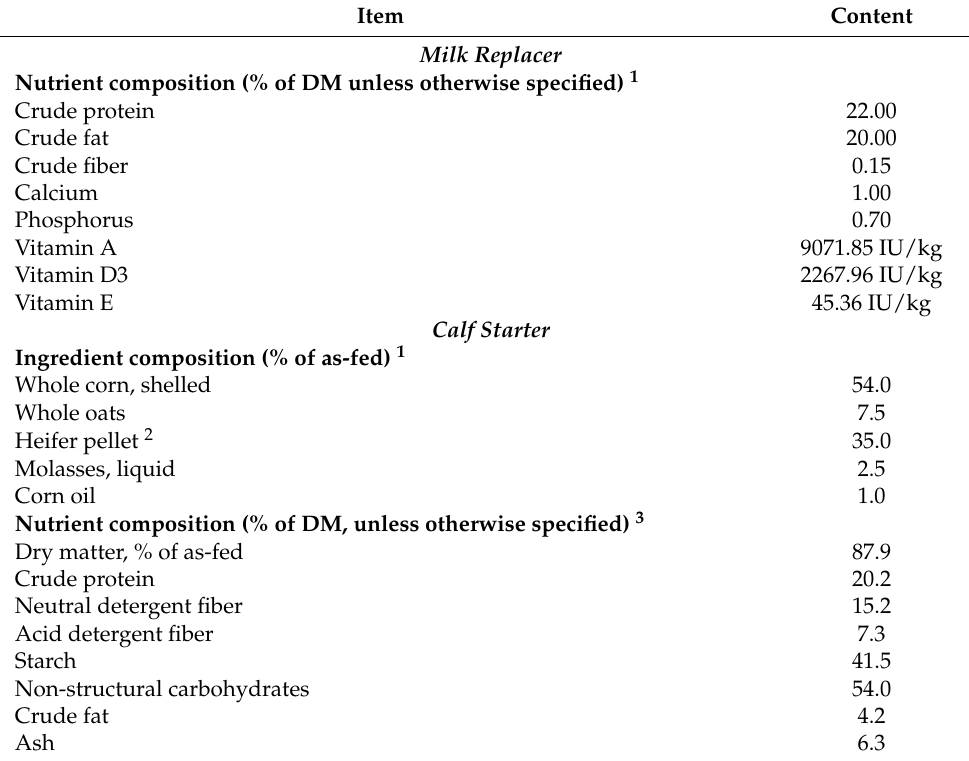
Table 1. Ingredient and nutrient composition of milk replacer and calf